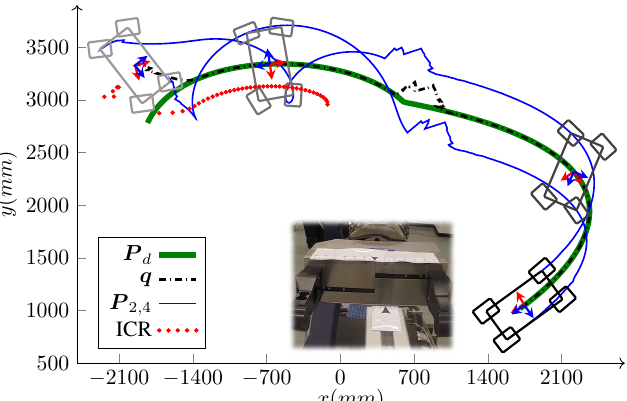
Figure 15. Experiment : Bounded velocity path-following with independent heading control of iMoro WMR ( δ = ( 1,2 ) ). It seeks and follows the path P d while correcting its heading from its initial heading to the desired heading of 360 ◦ at the end of the path.